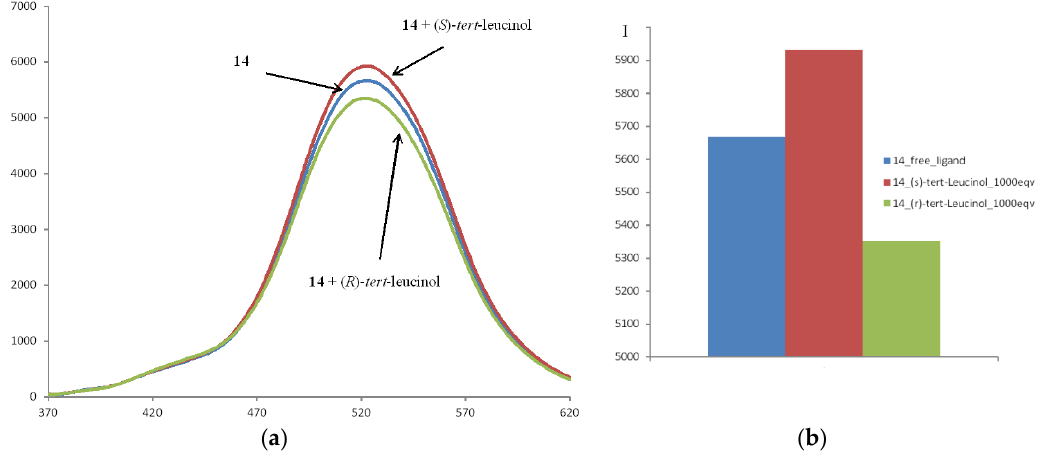
Figure 3. Fluorescence spectra of compound 14 in the presence of ( R )- and ( S )-enantiomers of tert -leucinol (1000 equiv.); ( a ) general view; ( b ) schematic representation of the changes in emission.